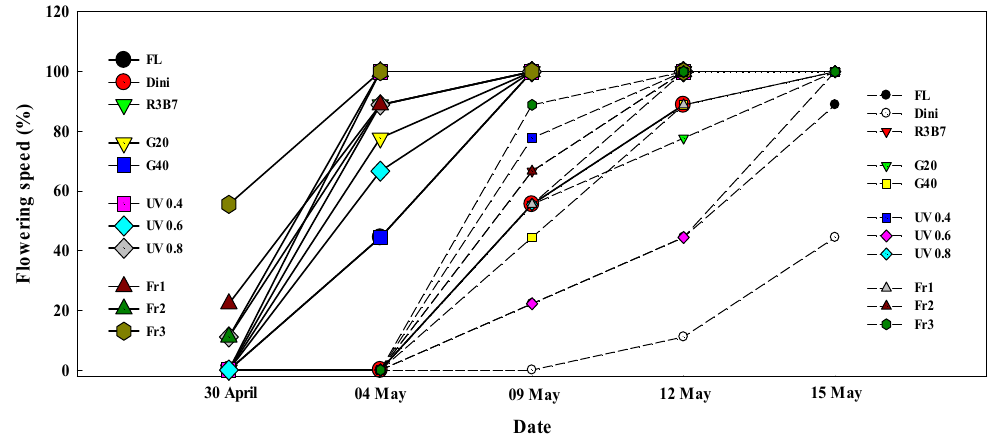
Figure 9. The effects of the light quality on the flowering speed of the first flower cluster (solid line) and second flower cluster (dotted line) of ‘Mini Chal’ tomato ( Solanum lycopersicum L.) after transplanting. Refer to Figure 1 for details on the light quality.